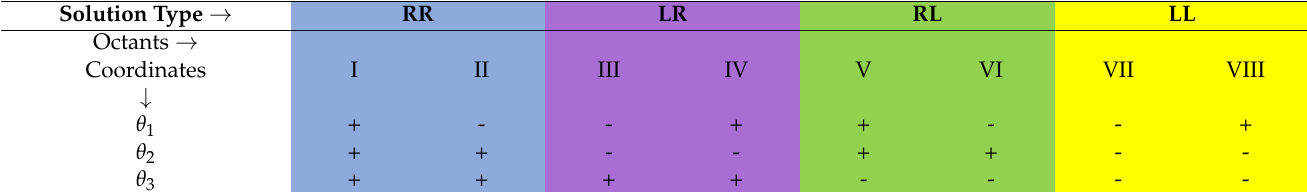
Table 1. Decision types and octants in the robot’s configuration space.